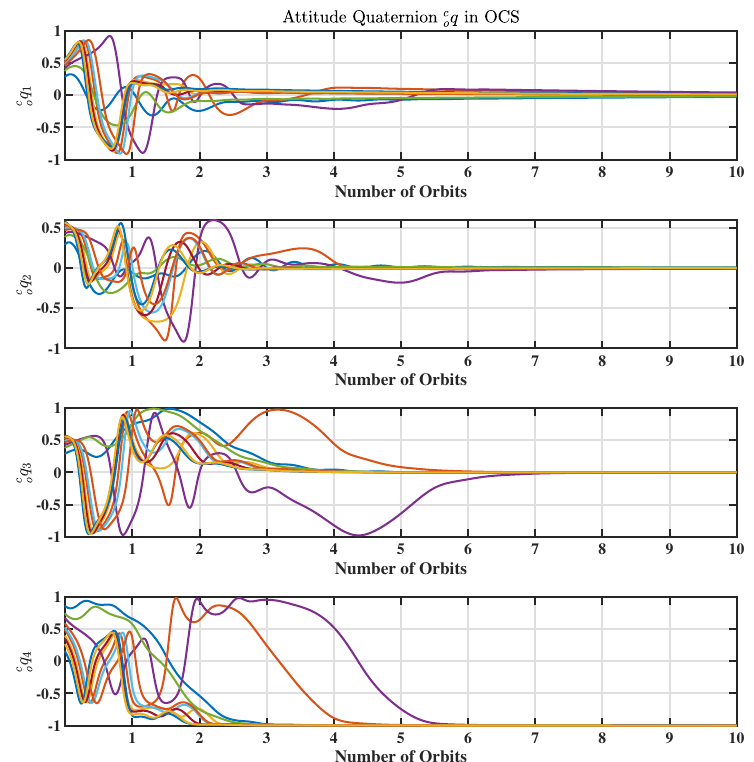
Figure 6. Quaternions converging to the local equilibrium point after starting from random initial quaternions (in a local neighbourhood). Subplots 1–4 represent quaternions q 1 – q 4 ,